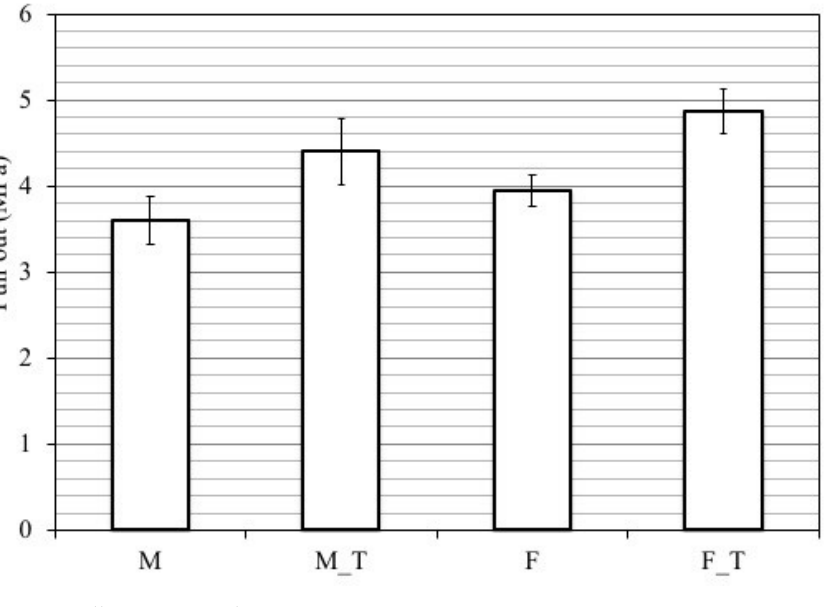
Figure 9. Pull-out test